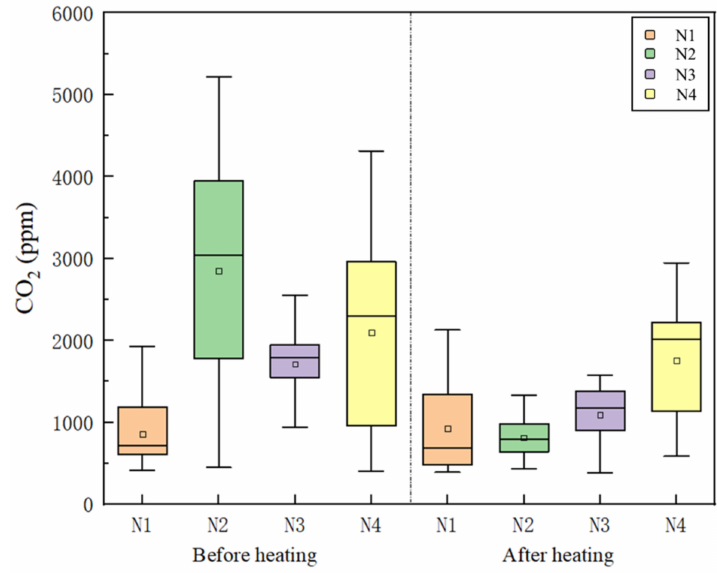
Figure 9. Box diagram of CO 2